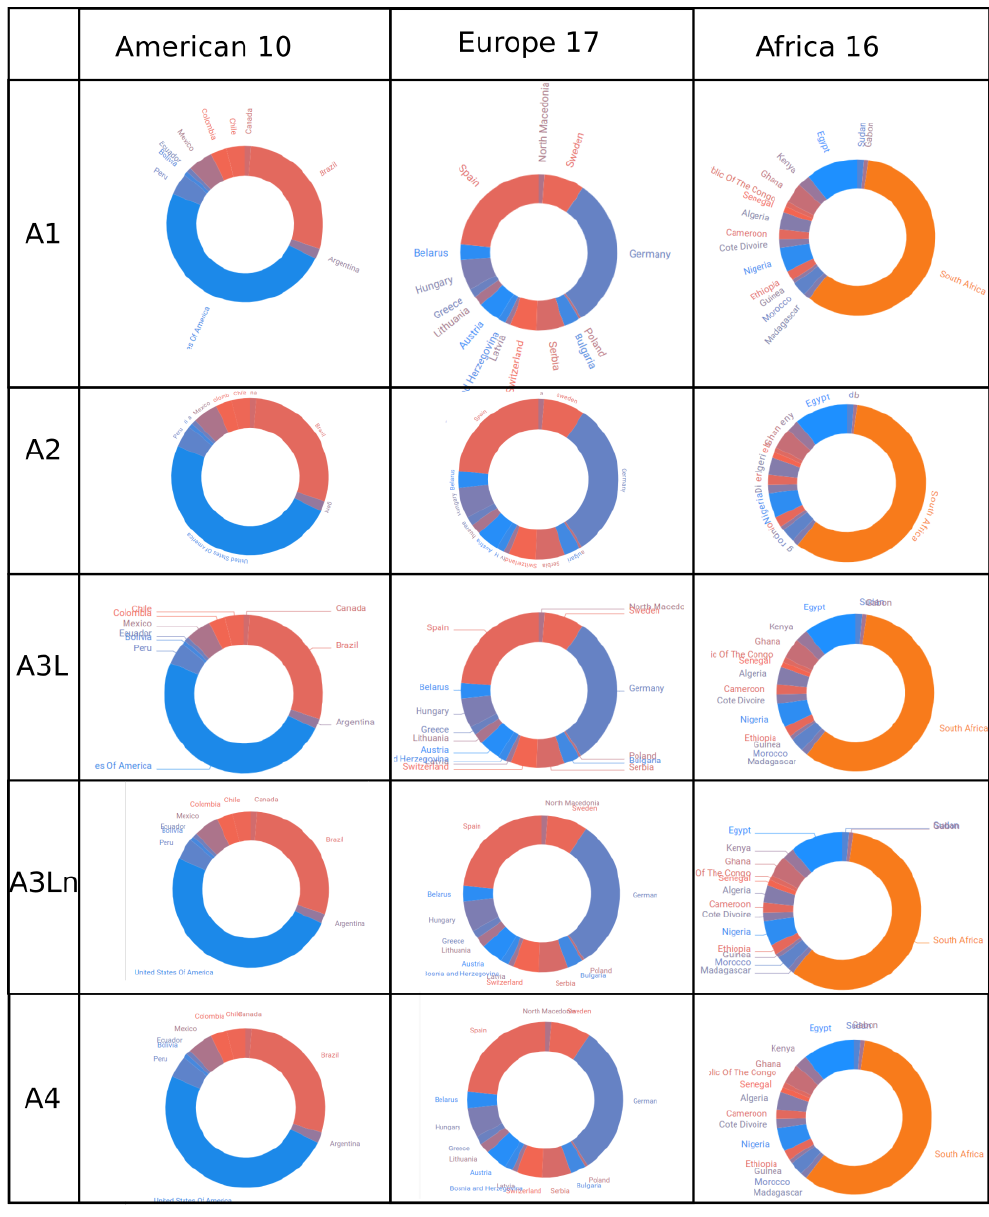
Figure 14. Visualization of proposed datasets with various label/arc